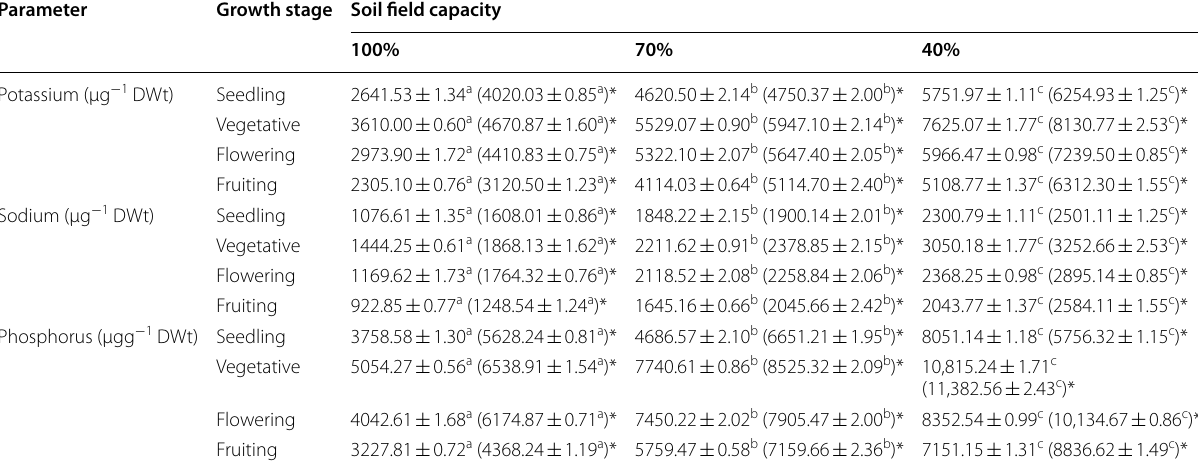
Table 10 One‑way ANOVA of elements of Ocimum basilicum under Drought and mycorrhiza